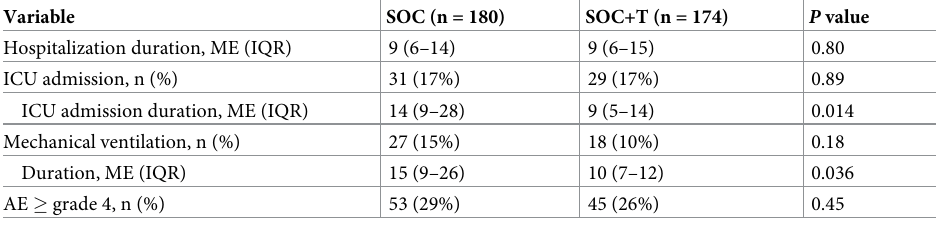
Table 2. Secondary outcomes at day 30.